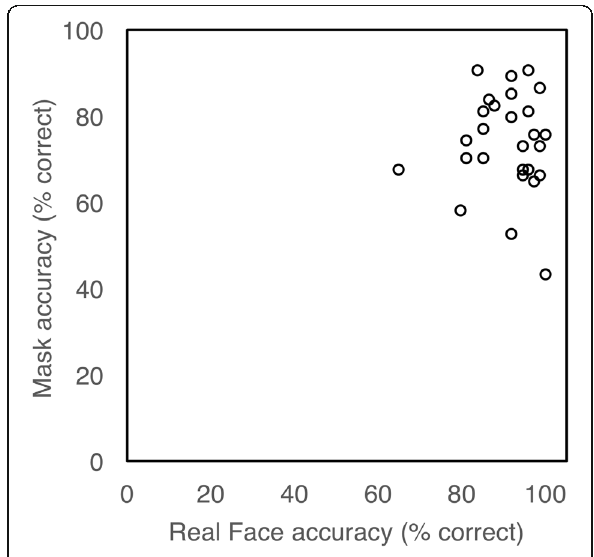
Fig. 7 Scatterplot showing participants ’ mean categorization accuracy rates in the real face and high-realism mask conditions in Study